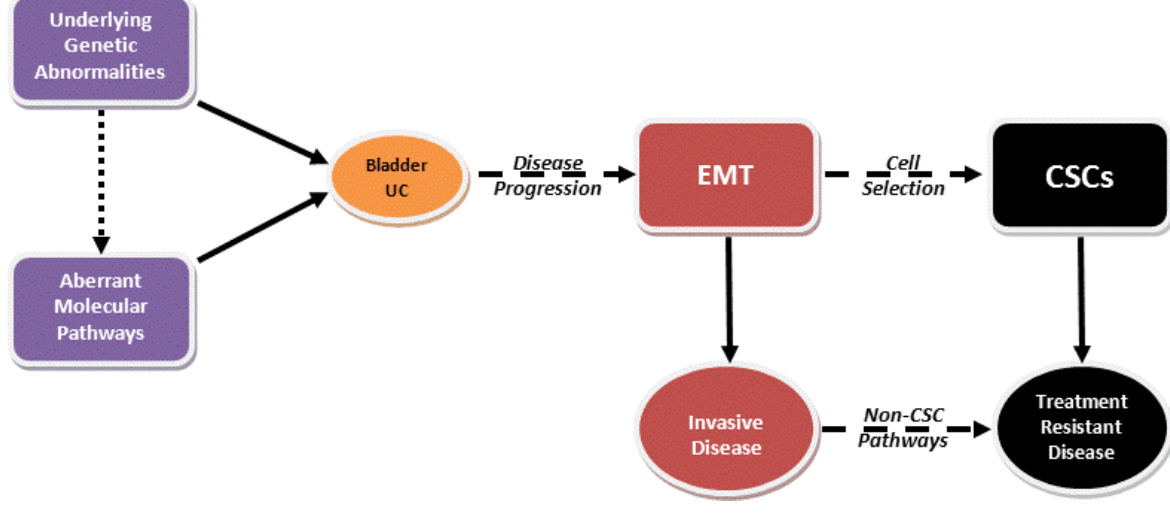
FIGURE 1. A proposed model for the development of bladder UC